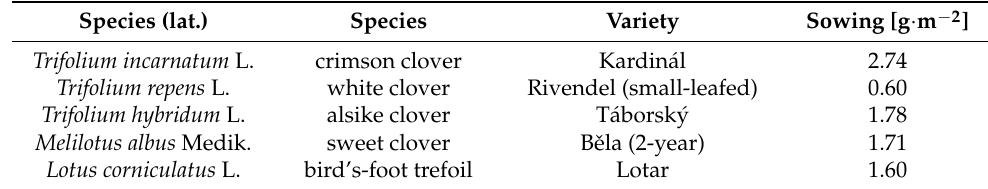
Table 1. Experimental arrangement according to the species, variety, and seed dose per square meter. Species (lat.) Species Variety Sowing [g · m − 2 ] Trifolium incarnatum L. Trifolium repens L. Trifolium hybridum L.